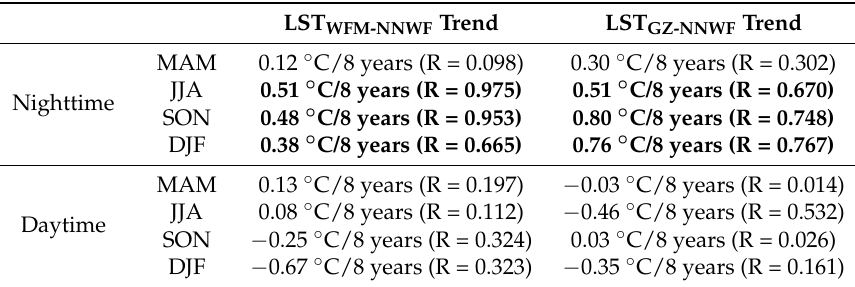
Figure 6. Inter-annual mean MODIS LST differences (°C) at nighttime for the period 2005–2012: ( a ) WFM minus NNWF; ( b ) GZ minus NNWF. Table 1. LST trends of the areal mean differences between WFM (GZ) and NNWF pixels during the four seasons from MODIS data for the period 2005–2012. R indicates the correlation coefficient. The trend significant at 5% level (R = 0.6319) is highlighted by bold characters.